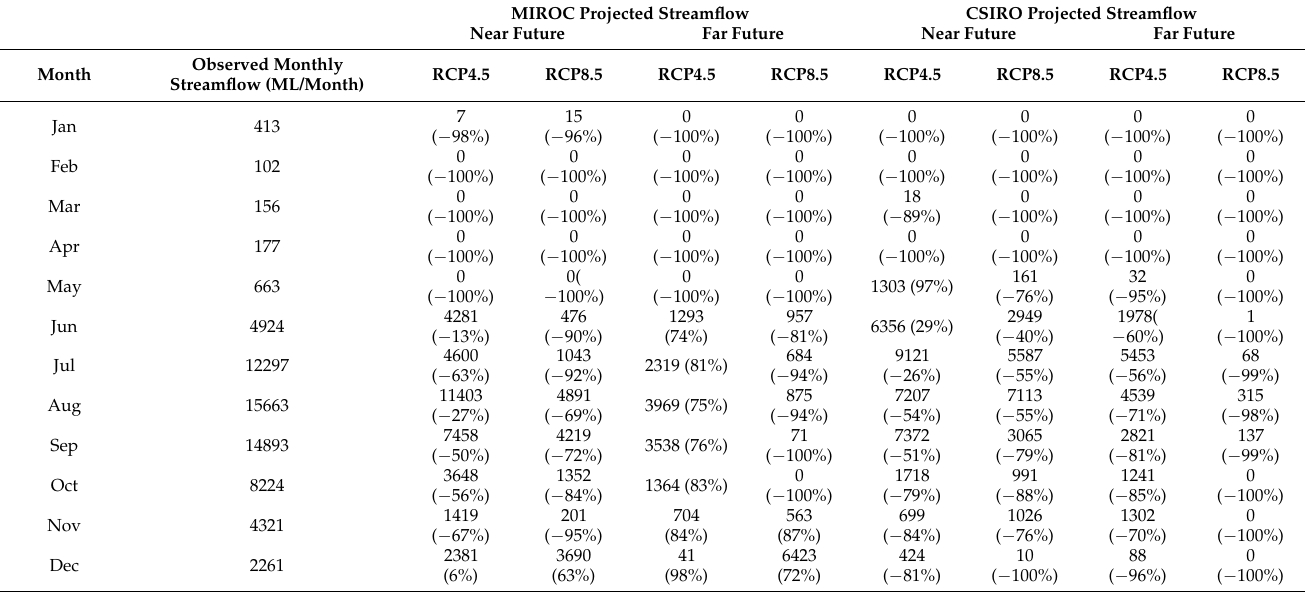
Table 6. Observed and projected monthly total streamflow